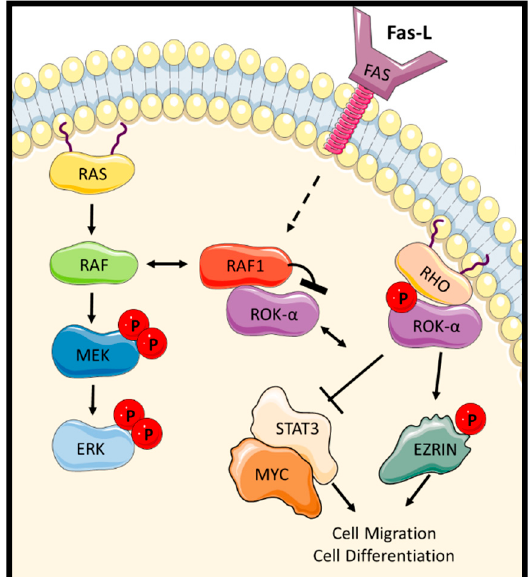
Figure 6. RAF1 interacts and inhibits the kinase activity of ROK- α . RHO binding to ROK- α rescues this kinase from the inhibitory effect of RAF1 and promotes the activation of cell migration and cell differentiation. FAS activation increases the formation of RAF1–ROK- α complex increasing apoptotic threshold.